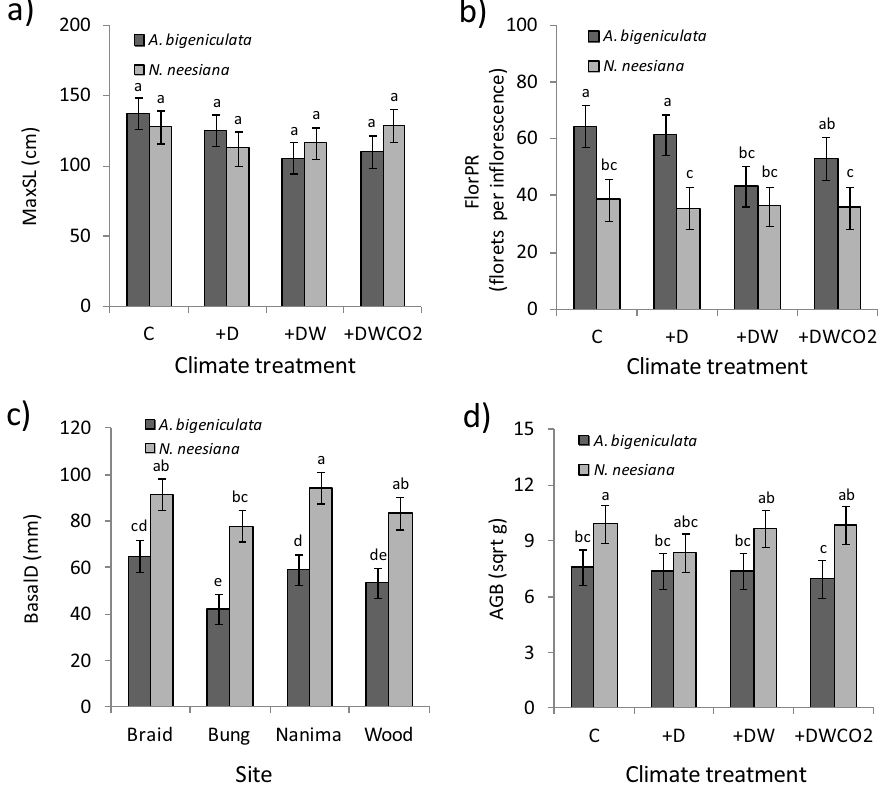
Figure 8. Reproduction and growth in A. bigeniculata and N. neesiana during Phase III of the experiment. ( a ) Maximum length of flowering stems (MaxSL) across climate treatments. ( b ) Floret production rate (FlorPR) across climate treatments. ( c ) Tussock basal diameter (BasalD) across study collection sites. ( d ) Above ground biomass (AGB) across climate treatments. Data are estimated means ± 1 standard error; means sharing the same letter do not differ significantly at the 0.05 level. In panel (a) estimated means differed at the 0.10 level (see text). Climate treatment and site acronyms are as in Figure